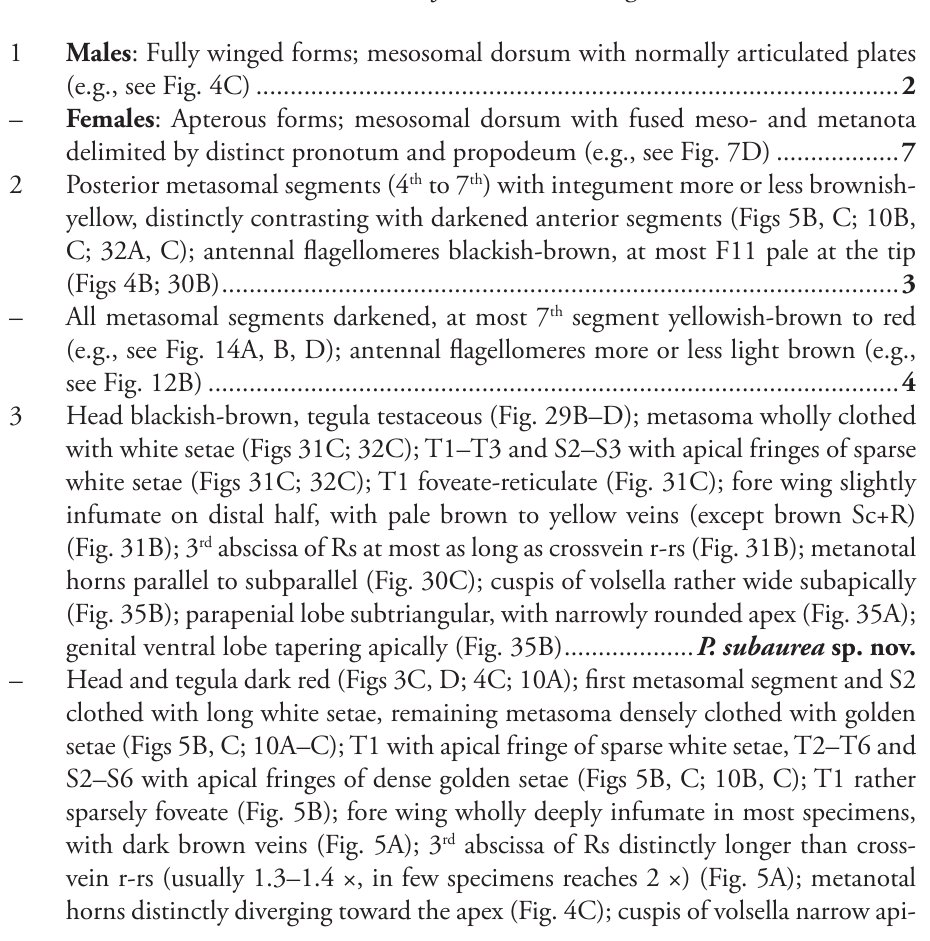
Head blackish-brown, tegula testaceous (Fig. 29B–D); metasoma wholly clothed with white setae (Figs 31C; 32C); T1–T3 and S2–S3 with apical fringes of sparse white setae (Figs 31C; 32C); T1 foveate-reticulate (Fig. 31C); fore wing slightly infumate on distal half, with pale brown to yellow veins (except brown Sc+R) (Fig. 31B); 3 rd abscissa of Rs at most as long as crossvein r-rs (Fig. 31B); metanotal horns parallel to subparallel (Fig. 30C); cuspis of volsella rather wide subapically (Fig. 35B); parapenial lobe subtriangular, with narrowly rounded apex (Fig. 35A); genital ventral lobe tapering apically (Fig. 35B) ................... P. subaurea sp.